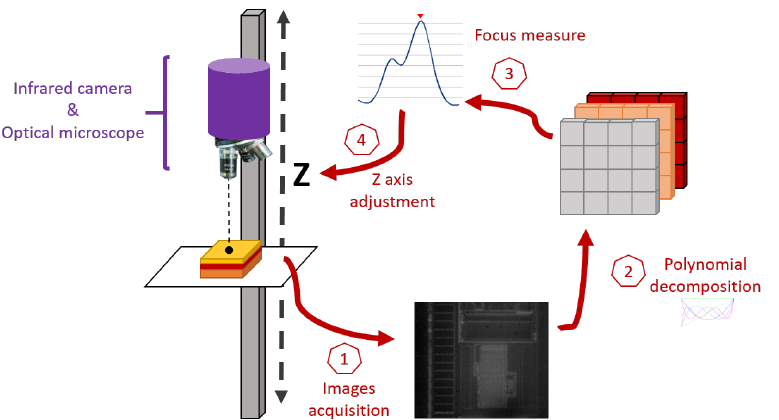
Figure 5. Representation of the autofocus framework using the Focus Metric based on POlynomial Decomposition (FMPOD): images are acquired at different distances to the IC, decomposed to compute the focus measurement that gives the best focus